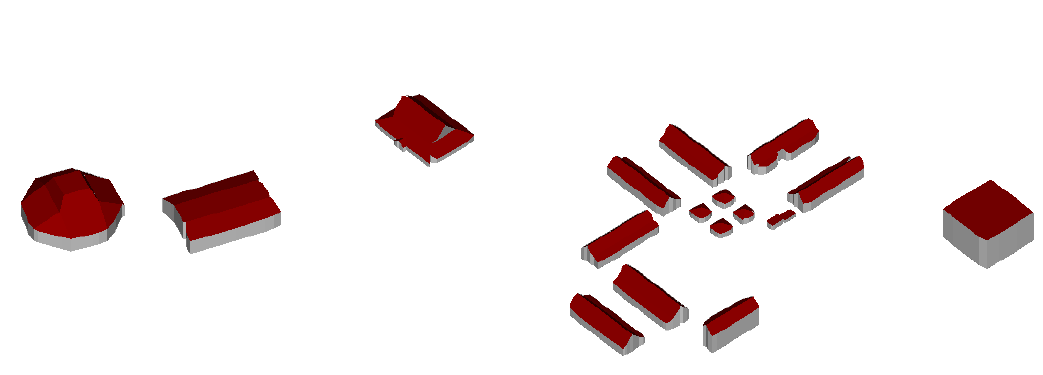
Figure 11. Resulting 3D CityGML models of the buildings generated by M_HERACLES and automatically converted using the Python function.